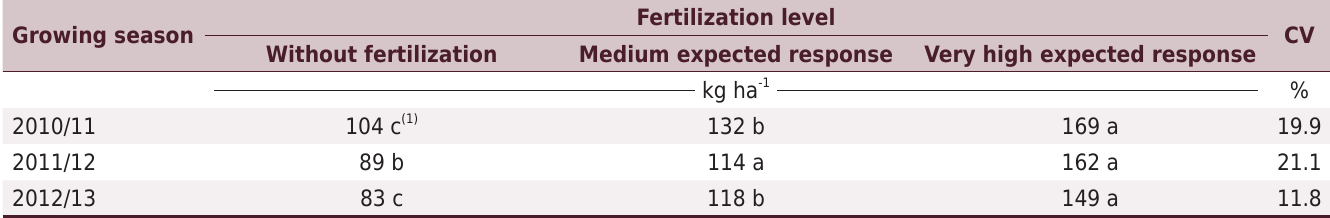
Table 4. Aboveground nitrogen accumulation in rice at anthesis grown with different fertilization levels Growing